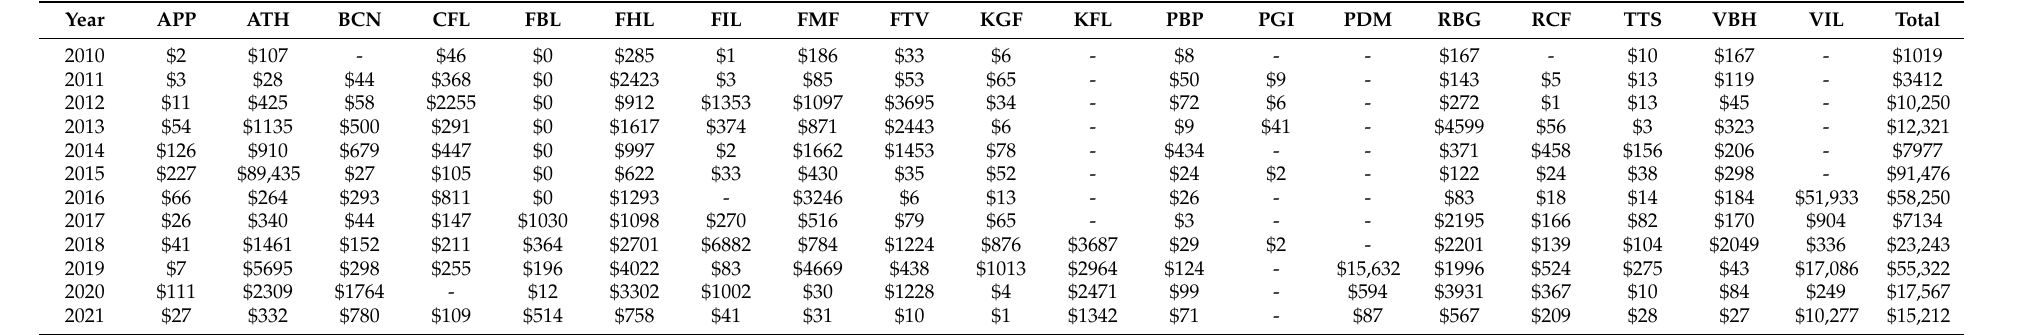
Table 9. Value of Trade Per Year (Millions of FJ$).